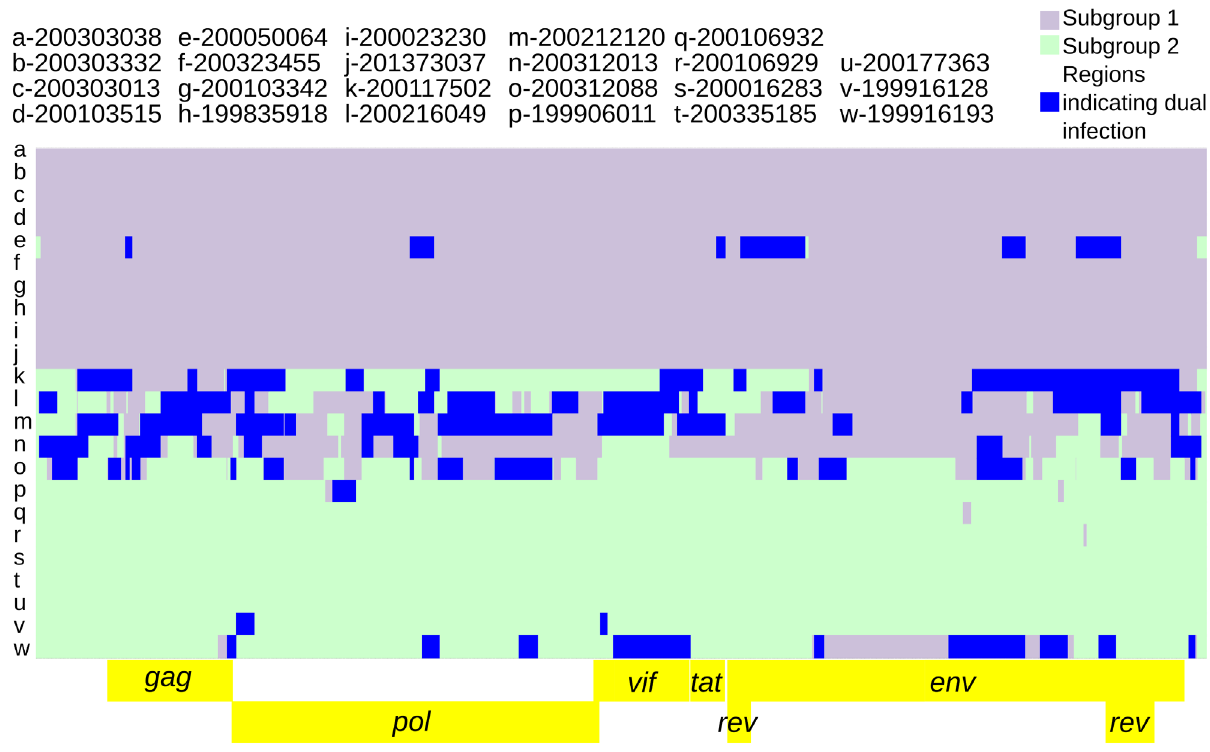
Figure 5. Twenty-three SRLV subtype A2 genomic regions indicative of dual infection. The background is the subgroup 1 vs subgroup 2 recombination model (Figure 4). Genomic regions indicative of dual infection contained both subgroup diagnostic alleles at a frequency ≥ 5% for at least 2 consecutive diagnostic SNPs and 50